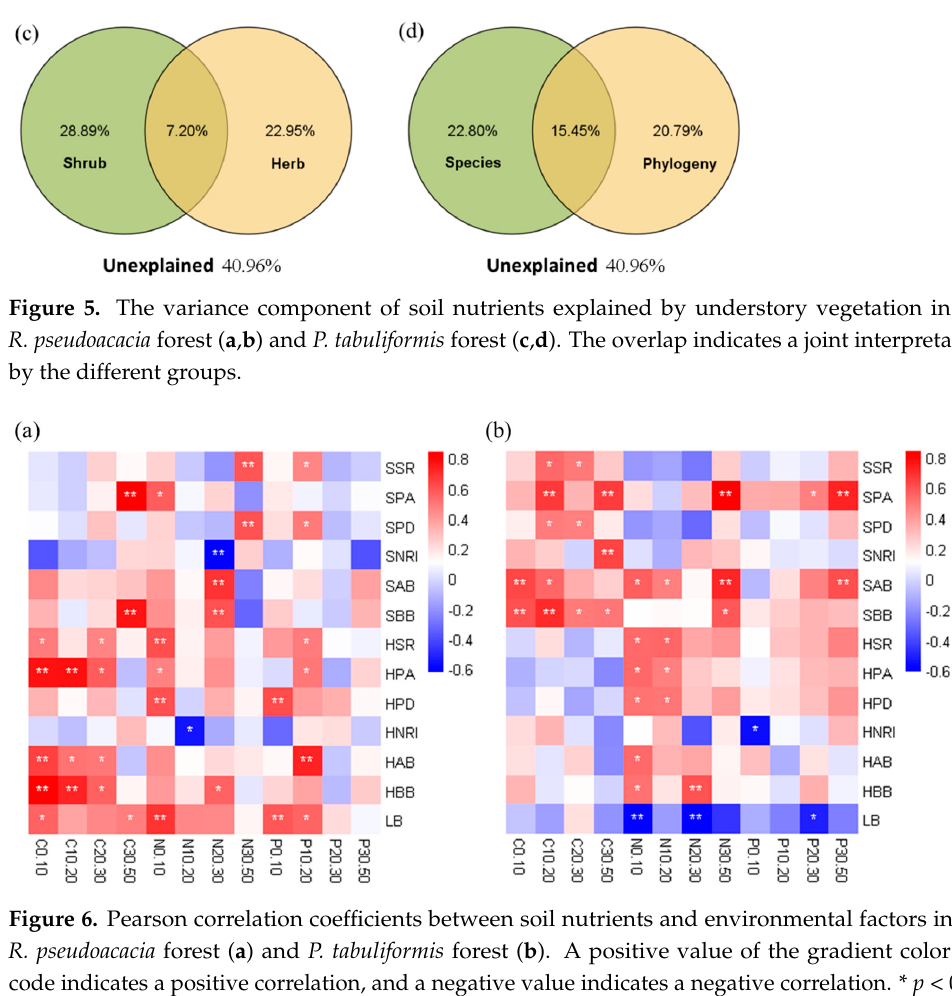
Figure 6. Pearson correlation coefficients between soil nutrients and environmental factors in the R. pseudoacacia forest ( a ) and P. tabuliformis forest ( b ). A positive value of the gradient color bar code indicates a positive correlation, and a negative value indicates a negative correlation. * p < 0.05, ** p < 0.01. SSR, shrub species richness; SPA, shrub plant abundance; SPD, shrub phylogenetic diversity; SNRI, shrub NRI; SAB, shrub aboveground biomass; SBB, shrub belowground biomass; HSR, herb species richness; HPA, herb plant abundance; HPD, herb phylogenetic diversity; HNRI, herb NRI; HAB, herb aboveground biomass; HBB, herb belowground biomass; LB, litter biomass. C0.10 to C30.50 represent the SOC of each soil layer; N0.10 to N30.50 represent the TN of each soil layer; P0.10 to P30.50 represent the TP of each soil